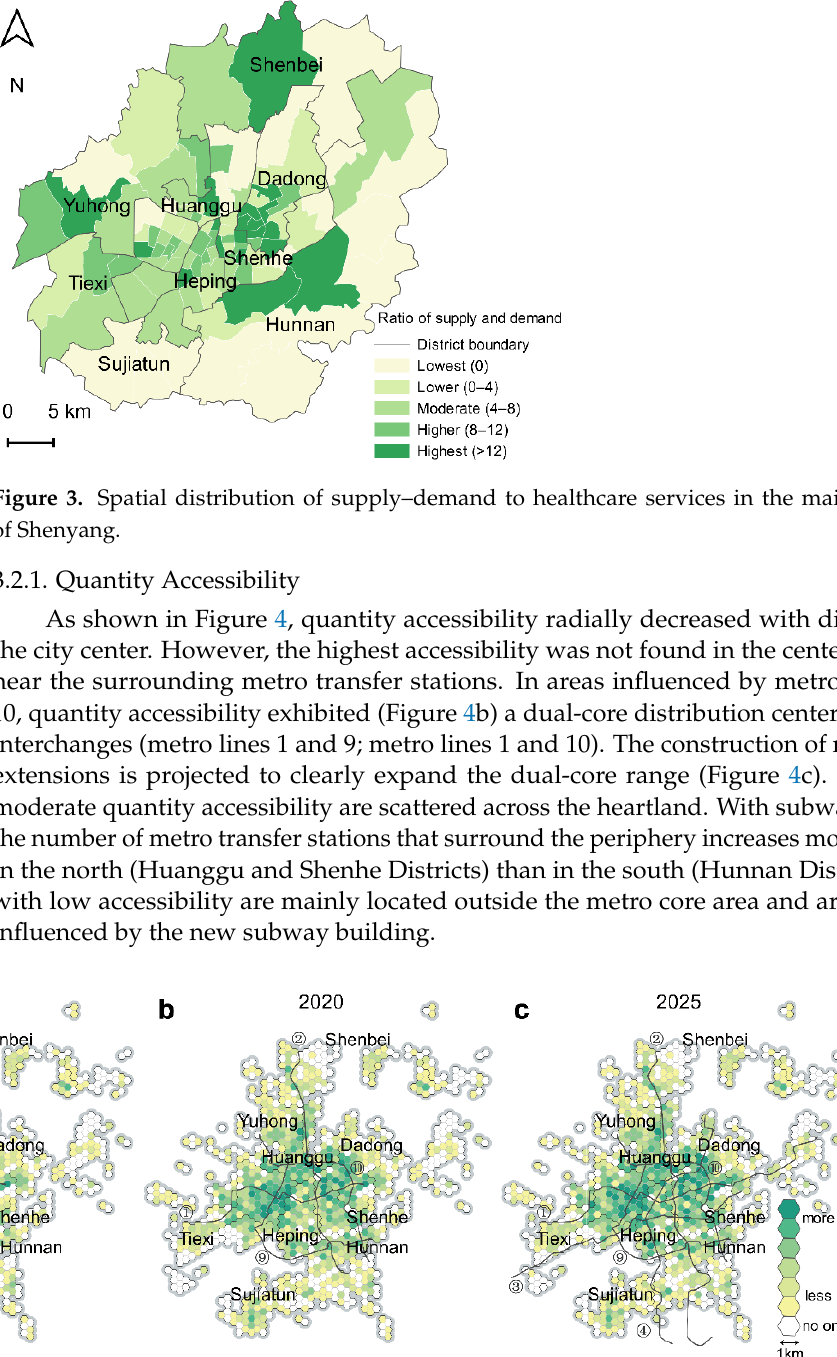
Figure 5. Spatial changes in residential zones with quantity accessibility ranking. 3.2.2. Quality Accessibility The spatial distribution of quality accessibility (Figure 6) is similar to quantity accessibility, and the healthcare quality available to residents increases as the subway expands. The healthcare quality in residential areas around metro line 1 is the highest, followed by successive decreases outside the core. Upgrading of the subway expands the highest-quality accessibility zones to the north with metro line 3 and west with metro line 10. Notably, the southern region changes little over the study period, which indicates that the healthcare quality available to the southern population is inadequate. This outcome is likely related to the Hun River obstructing subway construction and the concentration of healthcare services in the heartland. Quality accessibility occurs in every district following subway upgrades (Figure 7). In particular, Heping and Shenhe Districts were influenced by metro lines 3 and 4. Because of the expanded subway, 6.19% of residential locations improved from low healthcare quality accessibility. In addition, 19.62% of residential locations experienced an increase in quality accessibility from moderate to high; most of these locations are in southern Hunnan and Huanggu Districts and are influenced by metro lines 9 and 10. In the dual- core region, the high-quality range expanded; specifically, 18.47% of residential locations newly achieved high-quality access to over the study period.